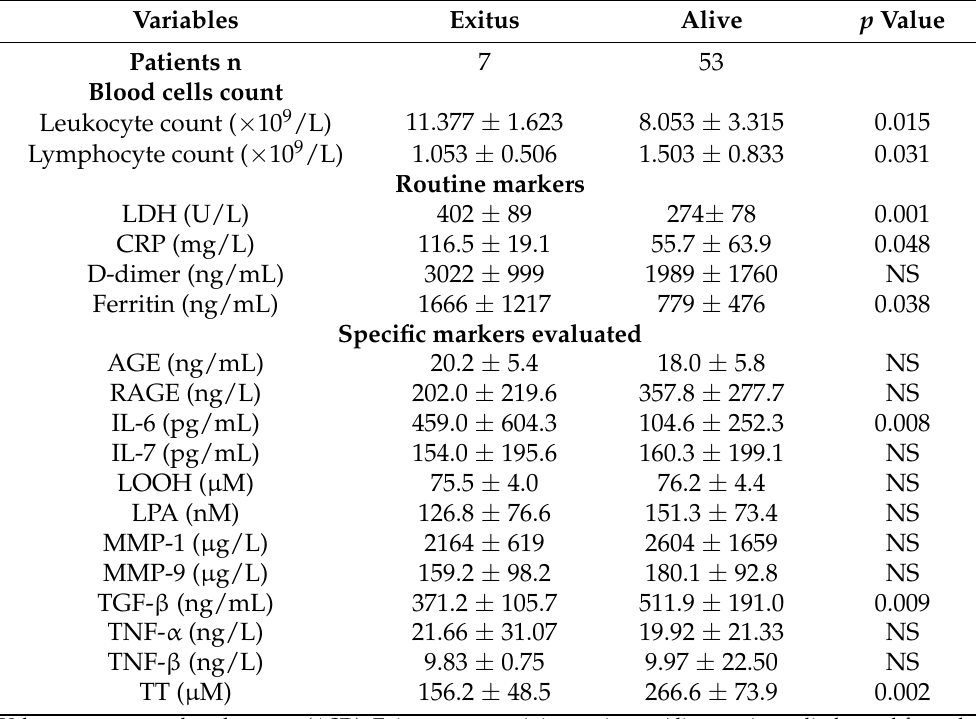
Table 4. Values of variables a week after hospital admission of the patients who survived and those who did not